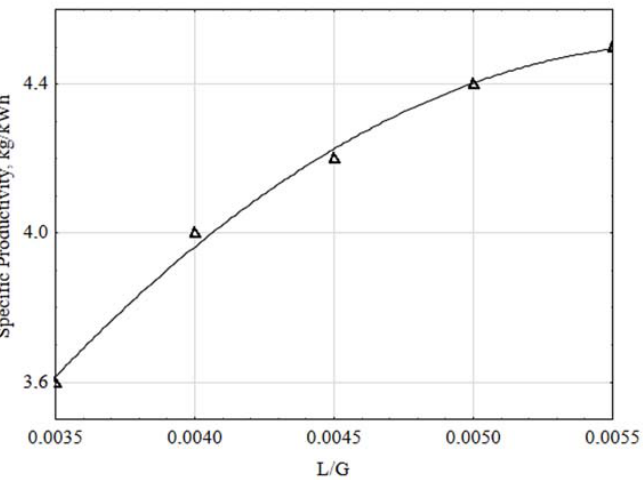
Figure 10. Specific productivity as a function of liquid (L) and gas (G) mass flow rate ratio.